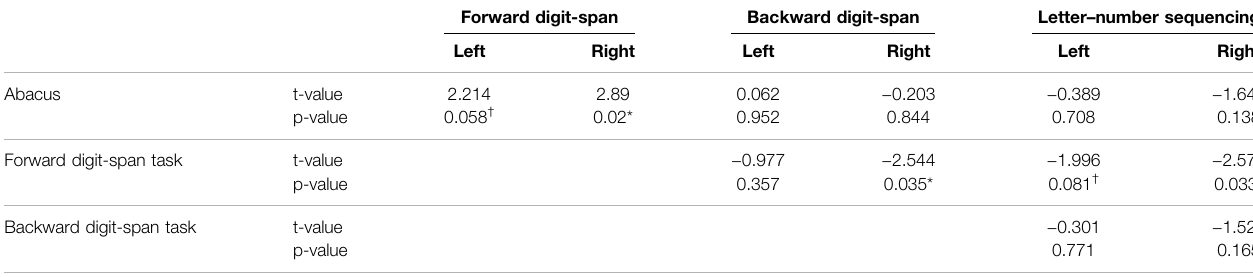
TABLE 2 | T-test values for each task.